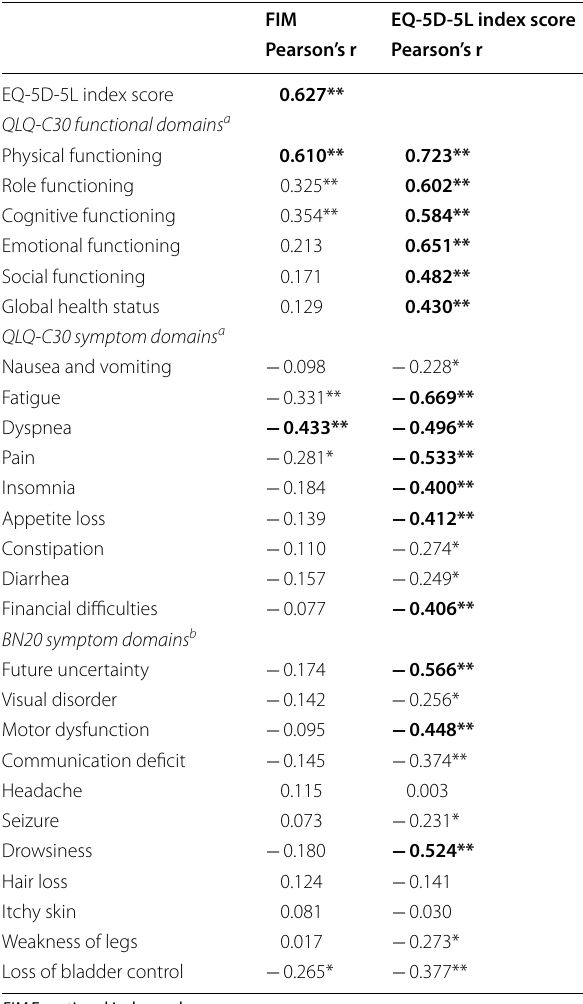
Table 4 Correlation between EQ-5D-5L index score, FIM, and disease-specific HQOL